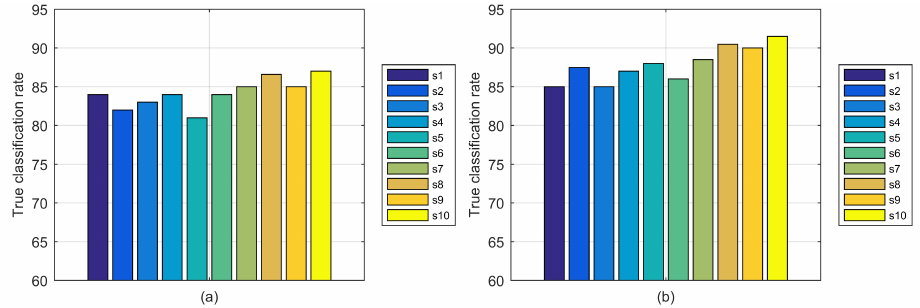
Figure 11. Classification results using different data fusion methods: ( a ) PCA subcarrier fusion; ( b ) averaging subcarrier fusion.